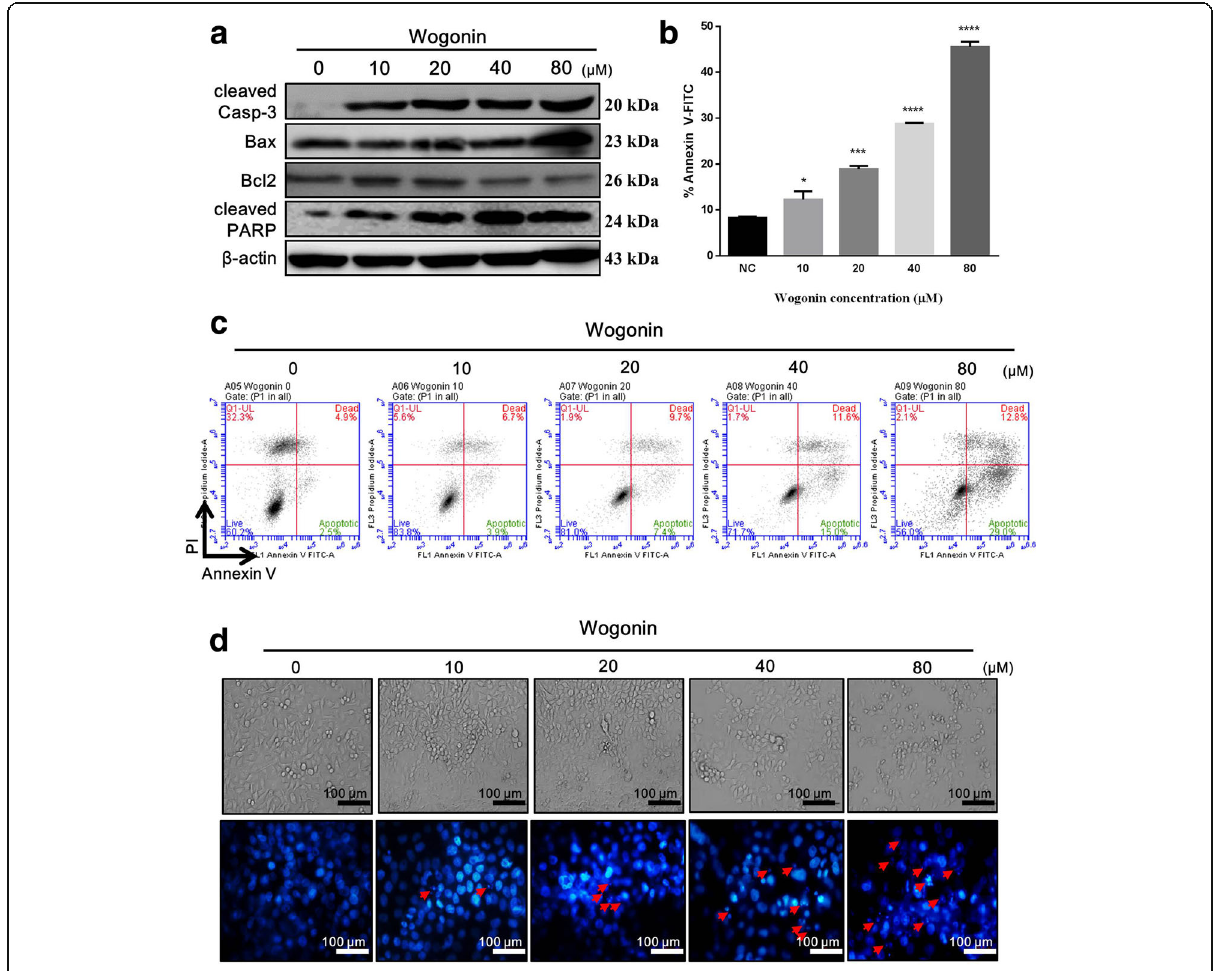
Fig. 1 Wogonin induces apoptosis in CD133 + CAL72 CSC. a Western blotting was performed on 24 h-treated extract of CSC in the presence of varying concentrations of Wogonin (0, 10, 20, 40, 80 μ M). b Percentage of annexin-V-positive cells after Wogonin treatment. c Percentage of apoptotic cells as analysed by flowcytometry. d The morphology of CSC was altered at 24 h post treatment; the changes in nuclear morphology were observed by Hoechst 33,342 staining after treating with the indicated Wogonin concentration (0, 10, 20, 40, 80 μ M). All experiments were performed in duplicates. Data are represented as mean ± SEM ( n = 3). ∗ P < 0.05, ∗∗ P < 0.01, **** P <